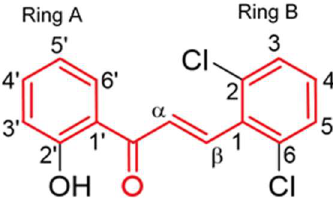
Figure 1. Structure of the synthesized chalcone 1 [( E )-3-(2,6-dichlorophenyl)-1-(2-hydroxyphenyl) prop-2-en-1-one]. The 1,3-diarylprop-2-en-1-one fragment is marked in red. Chalcone 1 was dissolved in dimethylsulfoxide (DMSO; PanReac AplliChem) and stored at 4 ◦ C in the dark. Prior to use, it was diluted in a cell culture medium to create the final concentrations (1.6, 3.1, 6.25, 12.5, and 25 µ M). The DMSO final concentration did not exceed 0.25% ( v / v